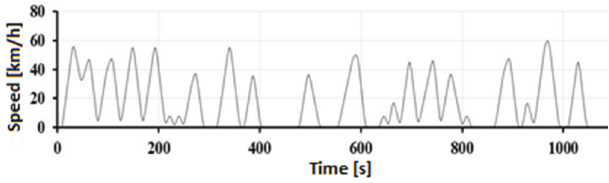
Fig. 5. Selected fragment of the speed course registered in stationary